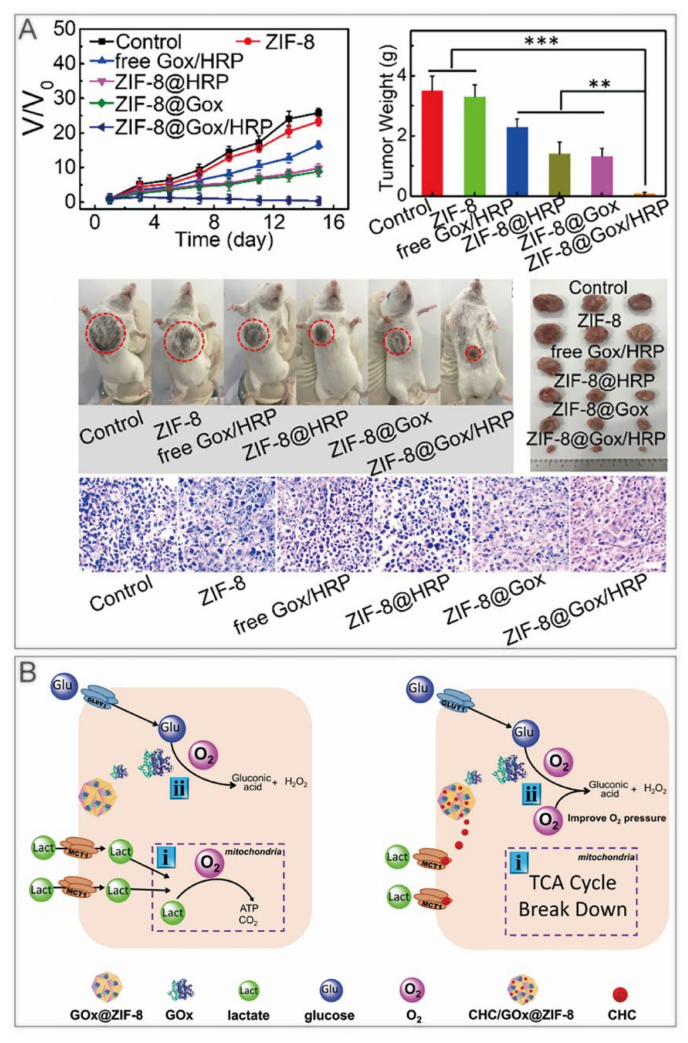
Figure 3. ZIF–8 nanoplatforms for individual ST. ( A ) ZIF–8@Gox/HRP inhibits tumor growth in